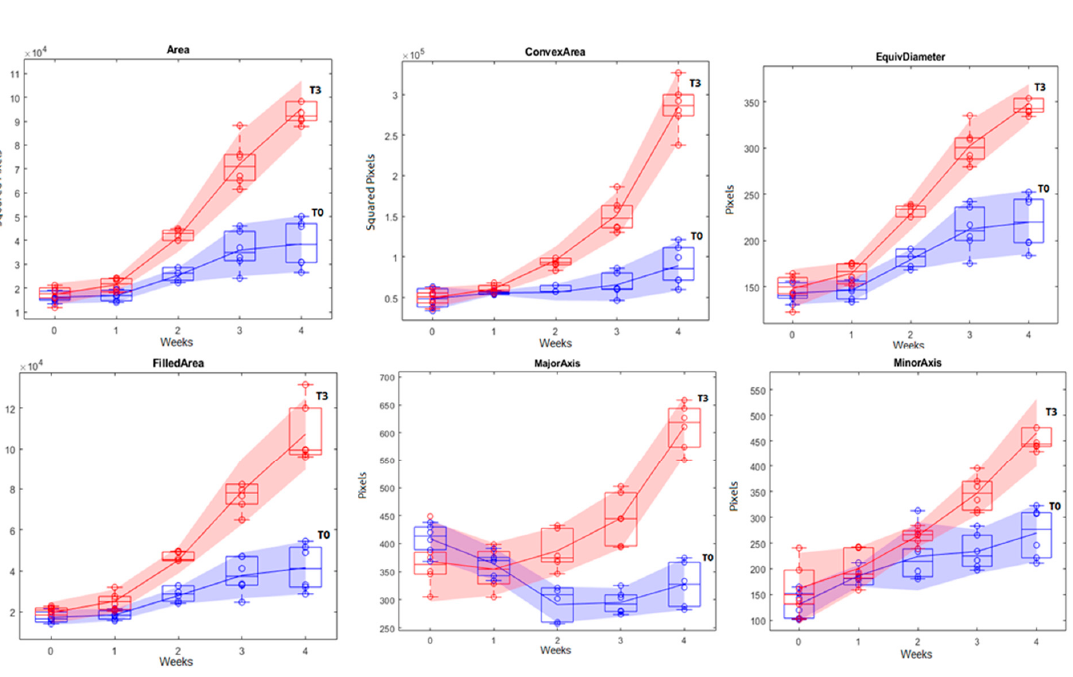
Figure 11. Functional boxplots showing morphological responses extracted from multispectral images correlating with number of weeks after transplant and fertilization treatments with a confidence interval of 95%. T0, T1, T2, and T3 were the four groups of plants treated with different amounts of fertilizer and vermicompost (see Section 2).